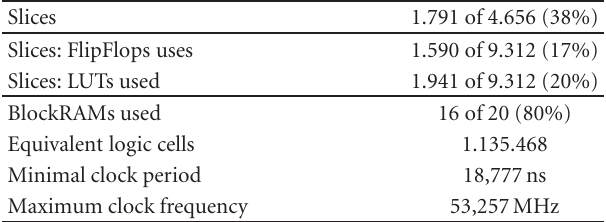
Table 7: FPGA resources.